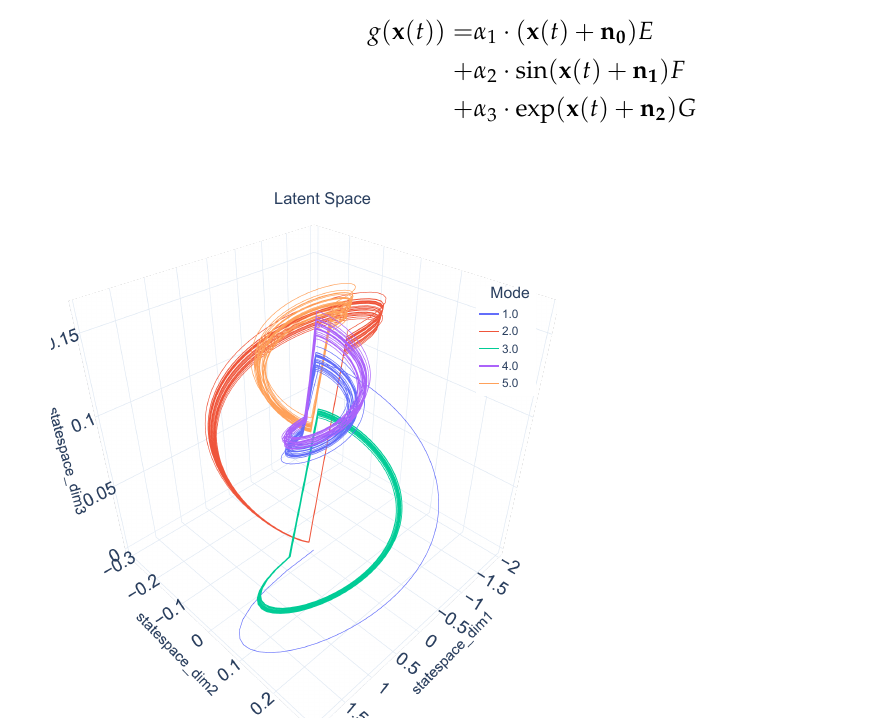
Figure 2. The latent space of x ( t ) ∈ R 3 of a third-order dynamical system over 25 cycles of a five- mode automaton. Every dimension of x ( t ) is shown as an axis and allows a graphical interpretation of the internal dynamics of the dynamical system from Equation (1). The colors indicate the trajectory taken to follow the commands within the automaton’s modes. It can be seen that each state has a unique